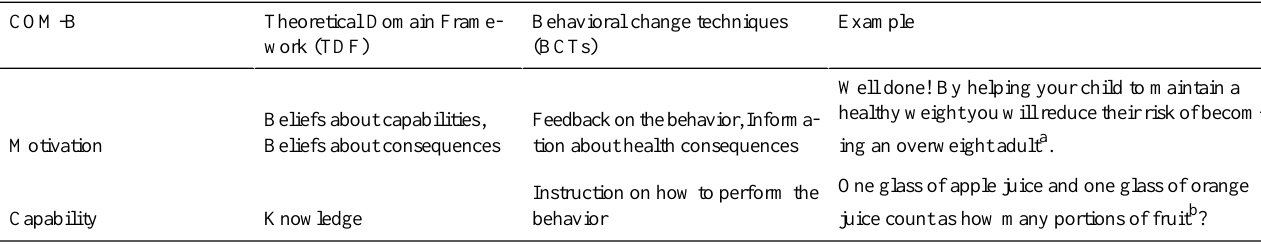
Table 7. Excerpt of content for within app messages, notifications, and quiz